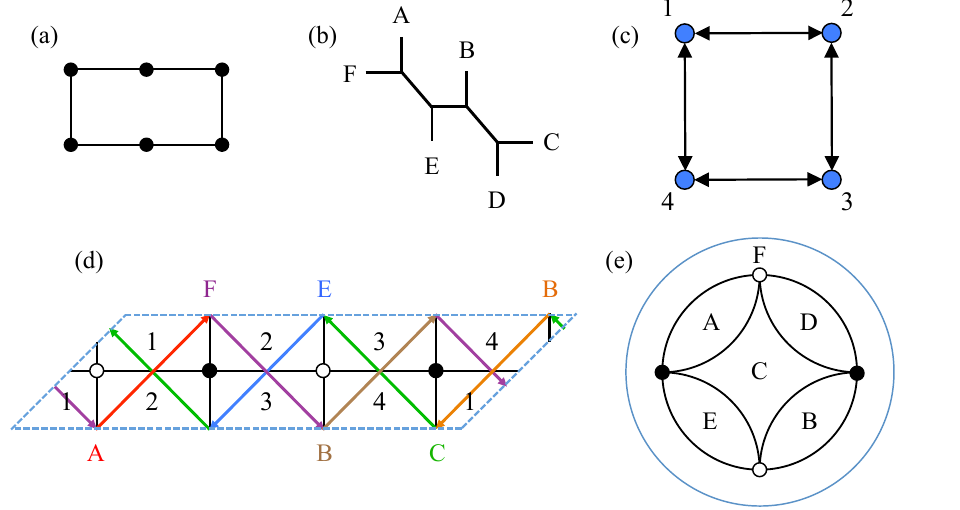
Figure 2. Various diagrams for the double conifold. a) Toric diagram. b) ( p; q )-web. c) Quiver. d) Dimer with zig-zag paths. The blue dashed parallelogram indicates the unit cell. Its opposite sides are identi(cid:12)ed to form a T 2 . e) The mirror Riemann surface (cid:6) is a sphere with 6 punctures. Here we represent it as the complex plane with the point at in(cid:12)nity, indicated by the blue circle,